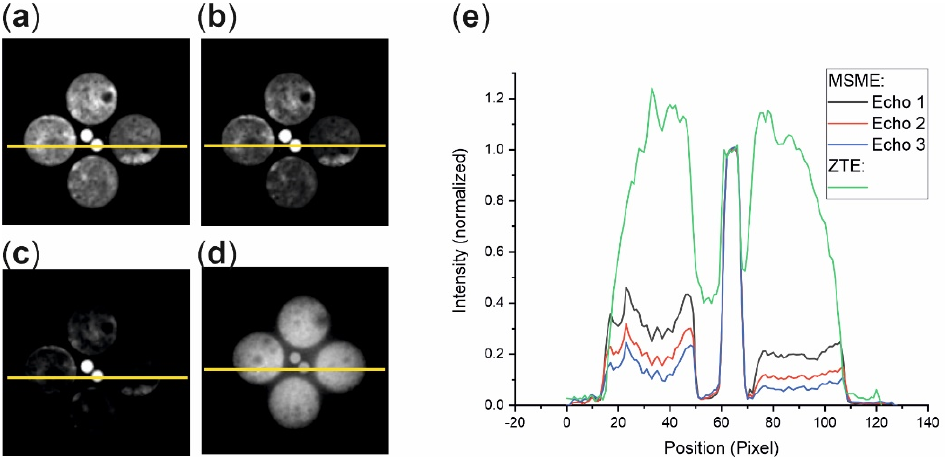
Figure 3. Comparison of MSME and ZTE images of sample S1. The marker tubes in the middle contained 33% water. ( a – c ) MSME images of a central axial slice through S1 of echoes 1, 2, and 3. Echo time t E = 1.6 ms, slice thickness = 2 mm, matrix size 128 2 , FOV: 7 × 7 cm 2 . ( d ) ZTE image of an axial slice, FOV 7 × 7 × 9 cm 3 , matrix size = 128 3 resulting in an in-plane resolution of 0.55 mm and a slice thickness of 0.7 mm. ( e ) Intensity profiles along the horizontal yellow lines, normalized to the intensity of the reference tube containing 0.33 vol-% water.